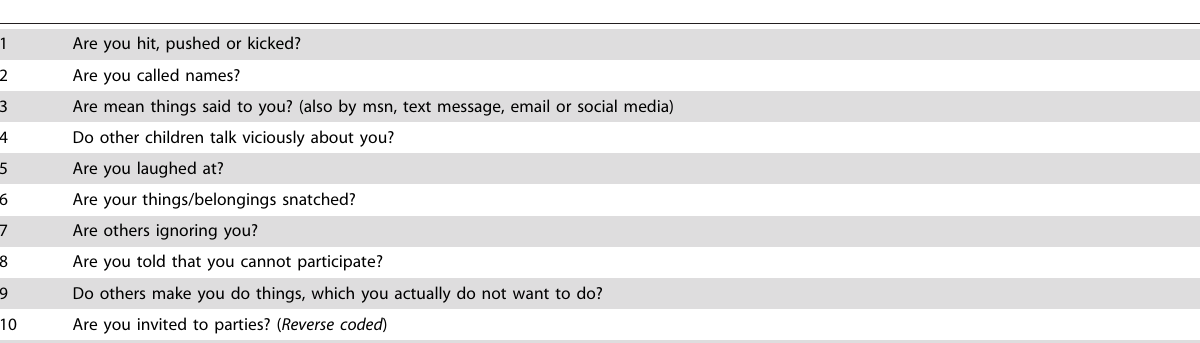
Table 4. Items in the Victimization